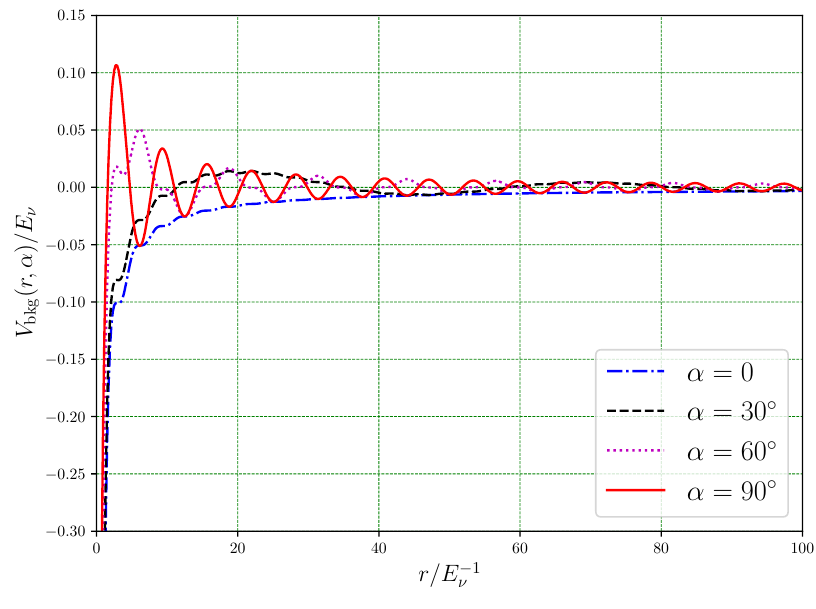
Figure 3 . Evolution of the directional background potential with the distance for α = 0 , 30 ◦ , 60 ◦ and 90 ◦ . Notice that the distance r is in the unit of E − 1 is in the unit of E for the background